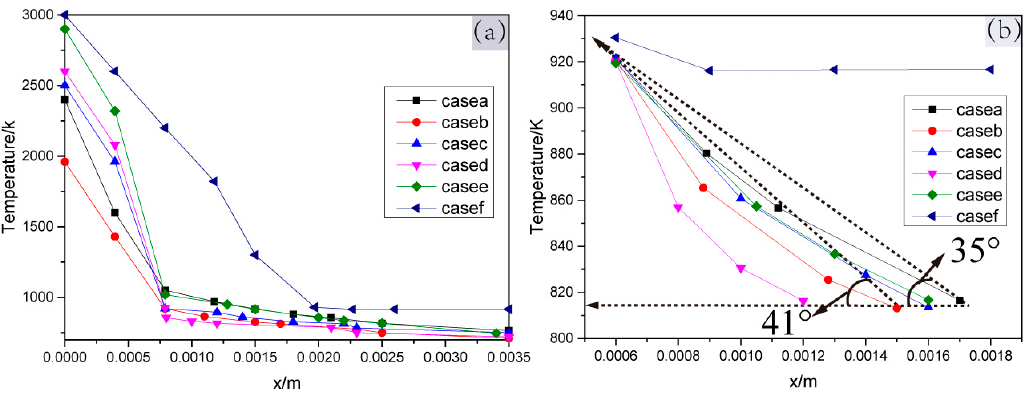
Figure 15. The temperature of the weld pool in the critical state of the keyhole perforation for case a-f. ( a ) Temperature gradient from 0 mm to the weld center. ( b ) Temperature gradient from 6 mm to the weld center.